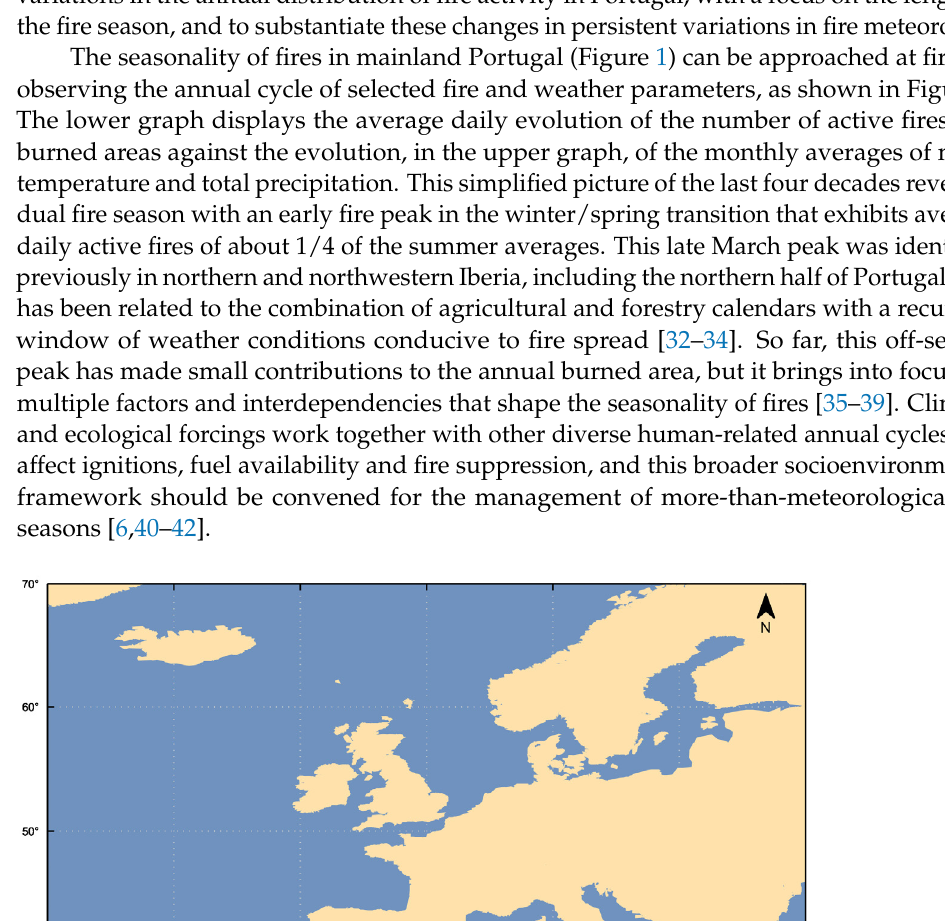
Figure 2. ( a ) Daily mean values of the number of fires (black solid line) and burned area (red vertical lines) in the period of 1980–2018. The peaks on 17 June and 15 October are mainly due to the excep- tional contribution of 2017. ( b ) Monthly average values of air temperature (orange line) and total precipitation (blue columns) over mainland Portugal (163 grid points) based on 30 years of ERA5 reanalysis (1981–2010). For details on data, see Section 2. 2. Methods and Data 2.1. Fire Activity Fire data were produced from the manually collected database of fire occurrences that has been organized nationally since 1980 [44–46], which was subjected to a systematic correction and standardization elsewhere and shared publicly for research [17]. It in- cluded a daily time series of burned area, which results from the sum of each fire’s daily ratio between burned area and fire duration in days. In summary, our working database included 189,734 fires that burned 4.6 million hectares between 1980 and 2018 (respec- tively, 25.8 and 98.5% of the original records).